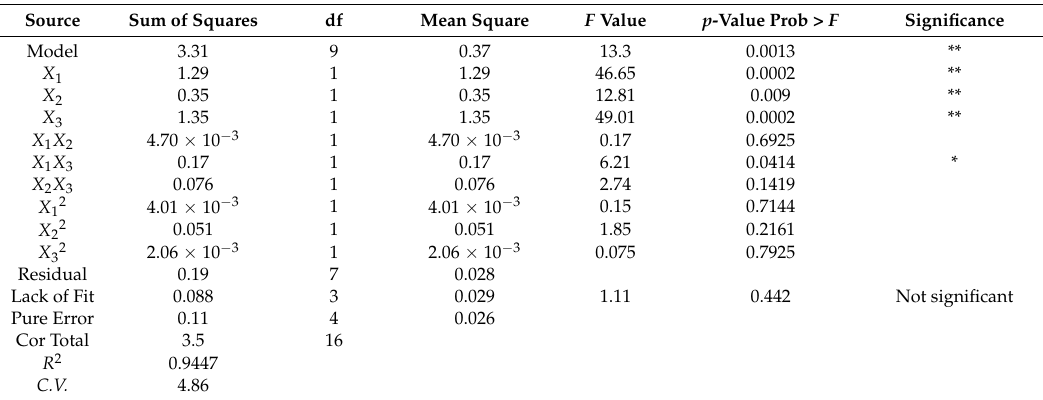
Table 3. Analysis of variance (ANOVA) for the quadratic